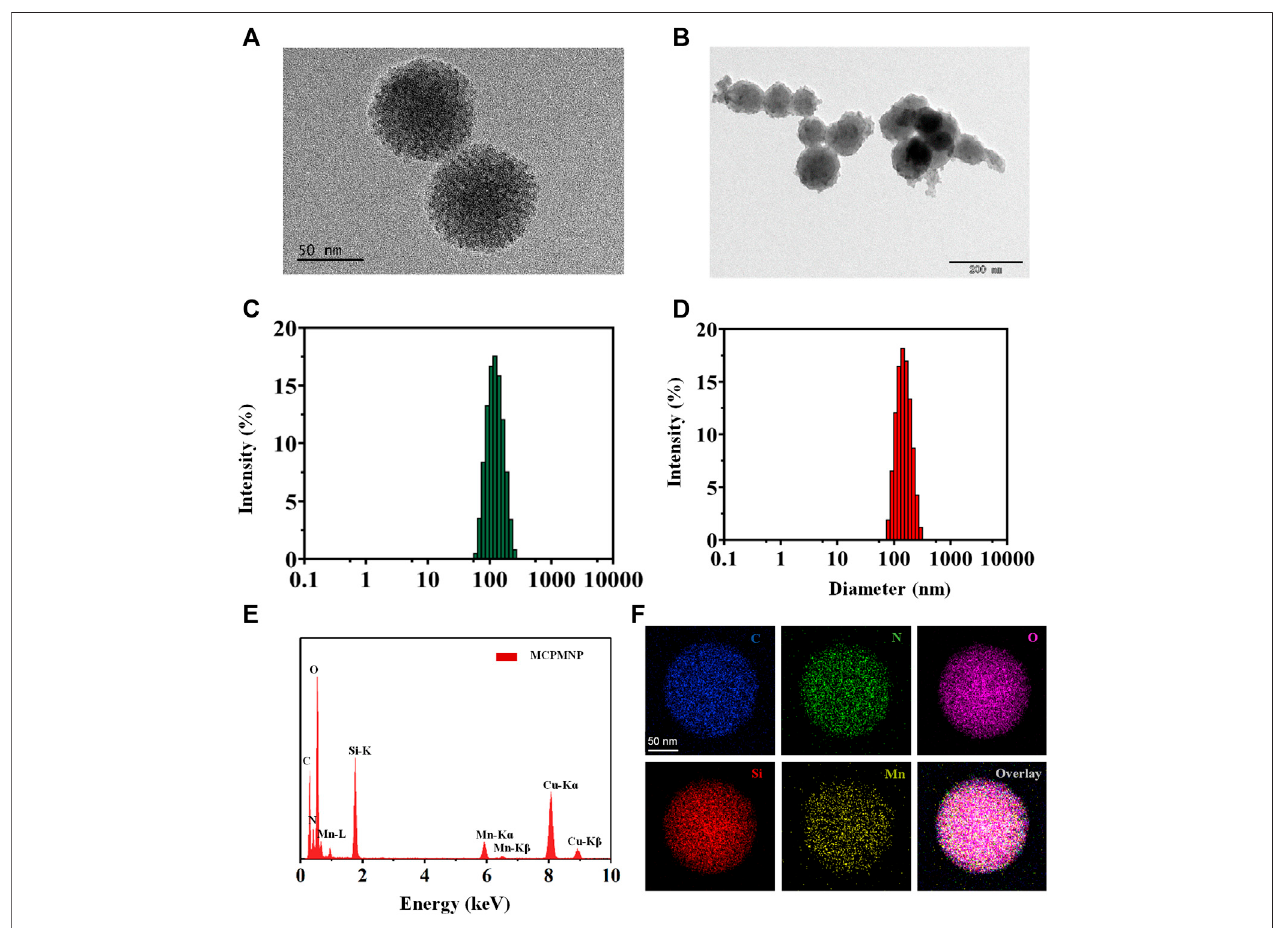
FIGURE 1 | Characterization of MSN and MCPM NPs. (A) TEM images of MSN. (B) TEM images of MCPM NPs. (C) Hydrodynamic size distribution of MSN. (D) Hydrodynamic size distribution of MCPM NPs. (E) EDS spectrum of MCPM NPs. (F) The elemental mapping images of MCPM